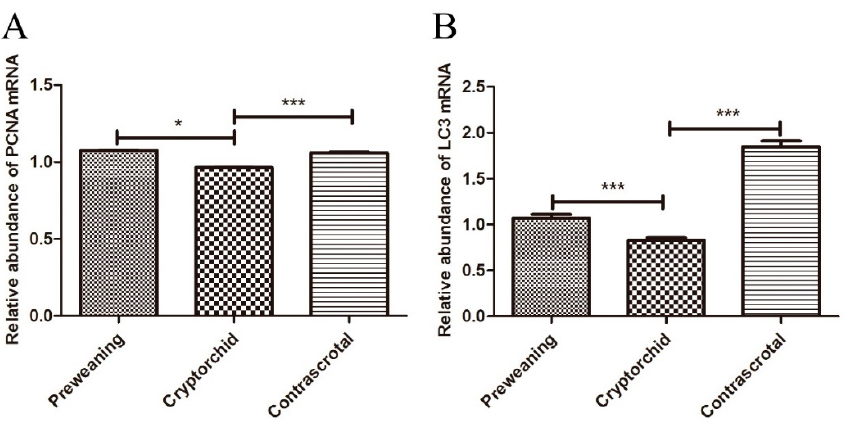
Figure 8. Relative expression levels of PCNA and LC3 mRNA in boar testes. Expression levels of PCNA and LC3 ( A ) and ( B ) mRNA in preweaning, cryptorchid, and contrascrotal testes. * p < 0.05, *** p < 0.001.